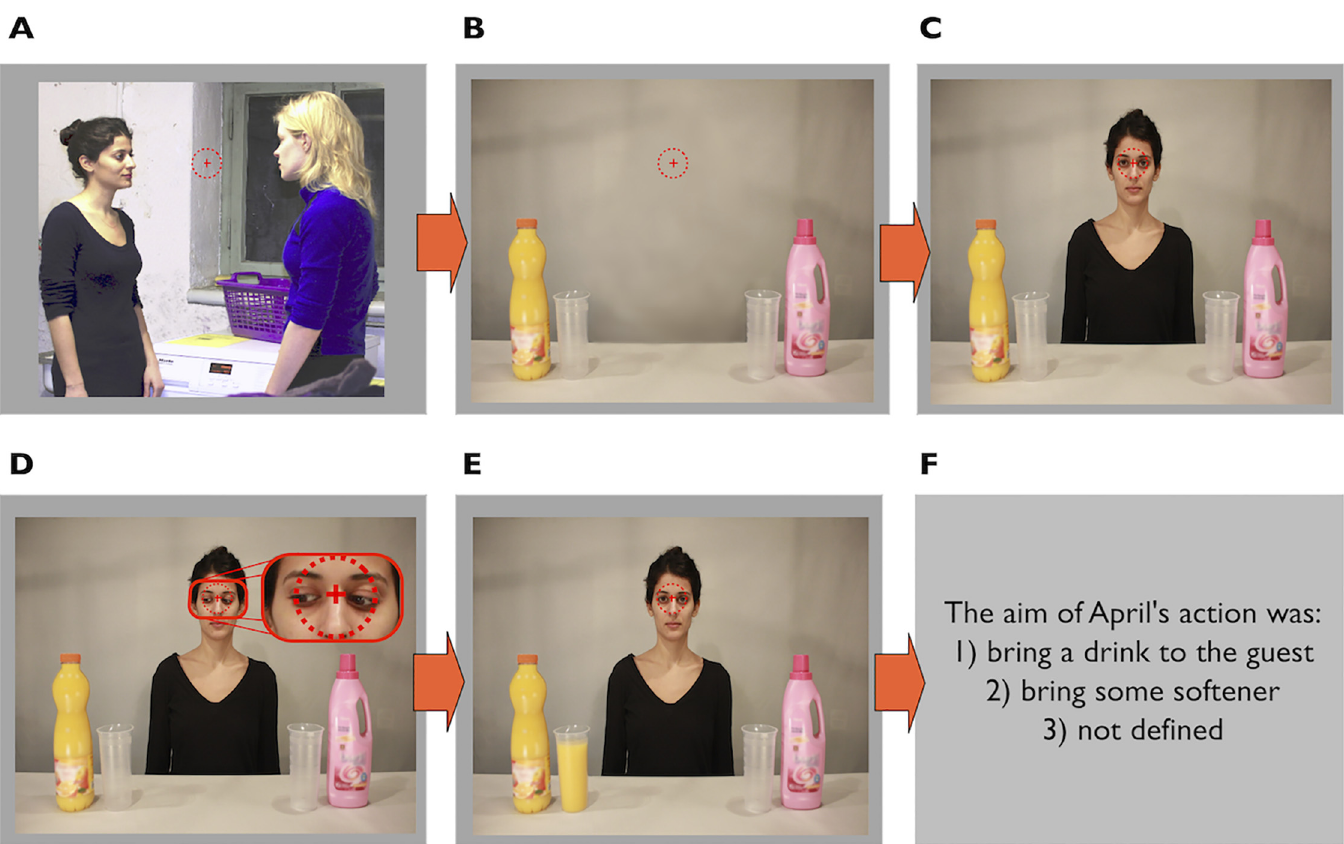
Fig 4. Schematic representation of an example trial in Experiment 2, with the same sequence of image frames as in Experiment 1 (Fig 1). The main difference between the experiments was that a fixation marker was presented throughout the image sequence. Participants ’ eye movements were restricted to a circular area (represented by the dotted circle) of a radius of 2° around the (center of the) fixation